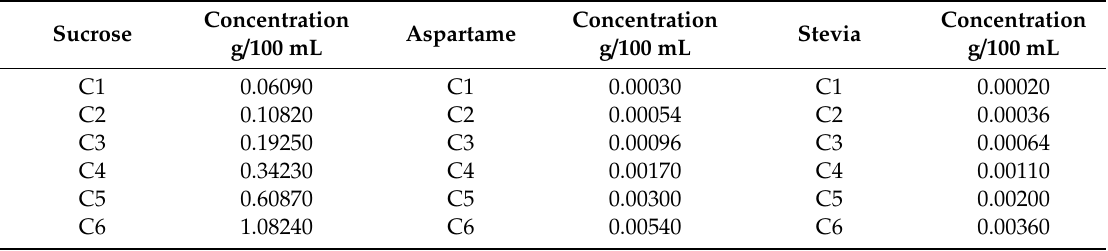
Table 1. Concentrations of sucrose, aspartame, and Stevia solutions used to evaluate subjects’ taste detection